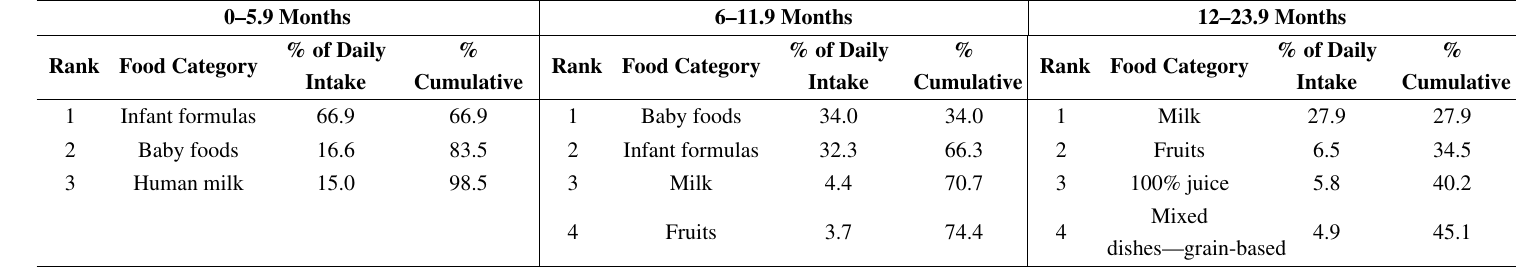
Table 16. Food sources of magnesium among US infants and toddlers aged 0–23.9 months by age group: NHANES 2005–2012 ( n = 2740) a